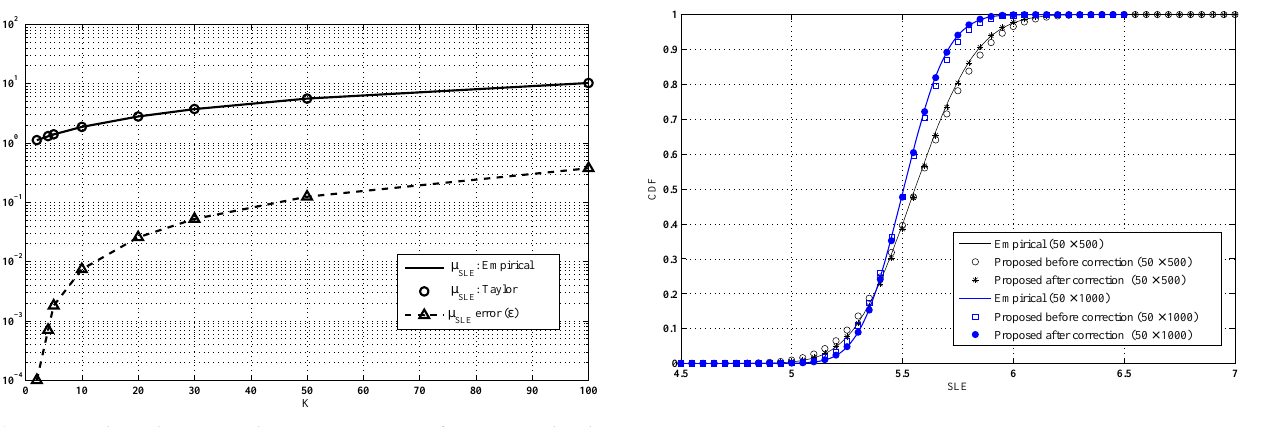
Figure 3. Empirical CDF of the SLE under H its corresponding proposed approximation for different values of K = 50 with N = { 500 , 100 } and r = − 10 dB .